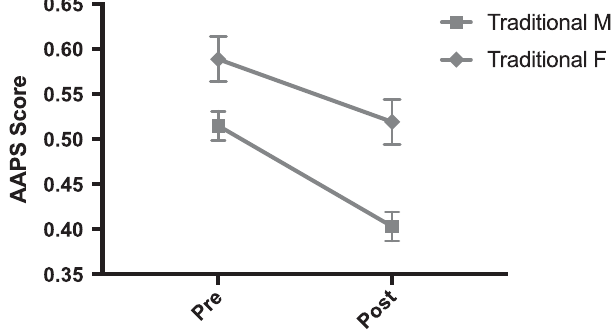
FIG. 5. Raw normalized data (i.e., without controlling for prescores) show the second semester AAPS survey scores by gender. Average male scores ( M ) are indicated by squares ( n ¼ 195 ) and average female scores ( F ) are indicated by diamonds ( n ¼ 58 ). Error bars represent standard error.